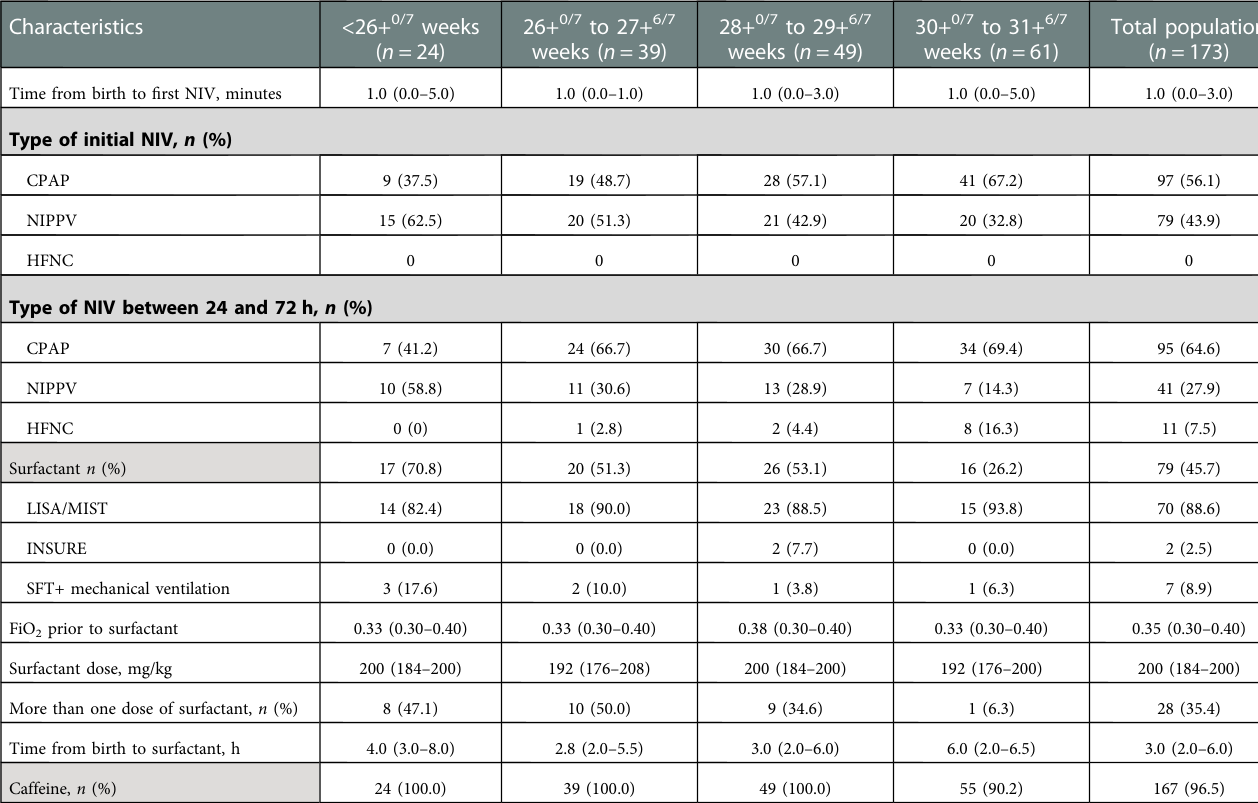
TABLE 2 Management of respiratory distress syndrome in the VENTIS study by gestational age.